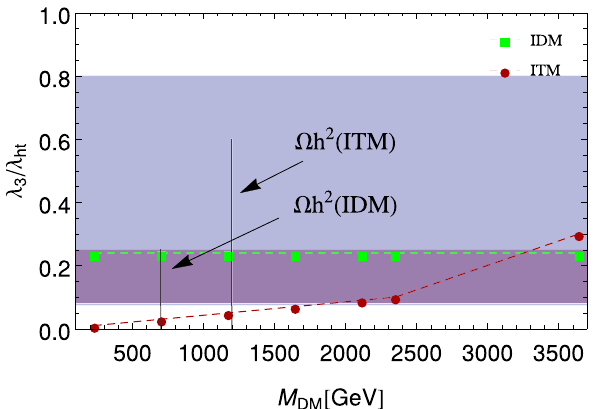
Fig. 12 Variation of DM mass with Higgs quartic coupling λ 3 in IDM and ITM. The light purple and blue color describe the allowed region by stability and perturbativity for IDM and ITM respectively. The black verticallinescorrespondtotherelicdensityboundsatisfiedbyDMmass 700, 1200 GeV for IDM, ITM respectively. The green and red coloured points describe the minimum value of M DM for a given λ 345 /λ ht for IDM and ITM respectively that satisfy the direct Dark matter constraint of XENON1T